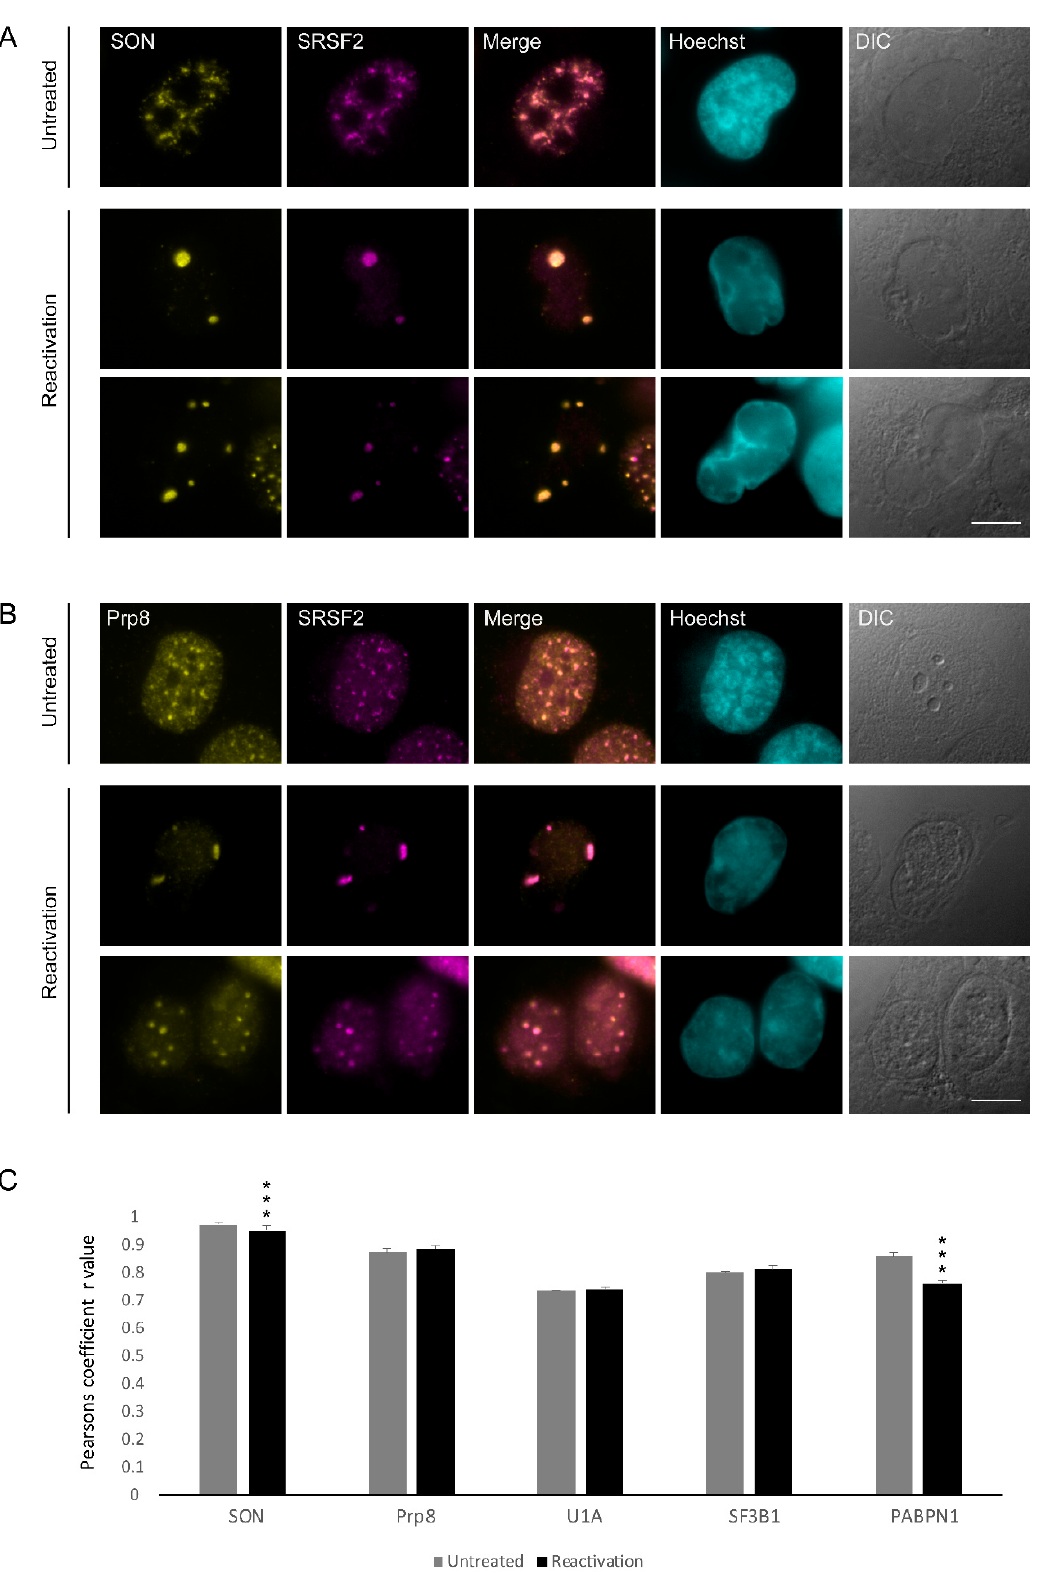
Figure 2. The distribution of SON and Prp8 during lytic reactivation of KSHV infection. BAC16 mCherry-ORF45-infected iSLK cells were treated to induce the lytic cycle of KSHV infection for 48 h and stained with ( A ) anti-SON or ( B ) Prp8 (yellow) together with SRSF2 (magenta); Hoechst in cyan; DIC in grey. Top row—untreated cells, bottom rows—reactivated cells. Bar, 10 µ m. ( C ) Pearson’s colocalization coefficient for the comparison of colocalization between SRSF2 and: SON (nUntreated = 116, nReactivation = 107 cells), Prp8 (nUntreated = 71, nReactivation = 65 cells), U1A (nUntreated =